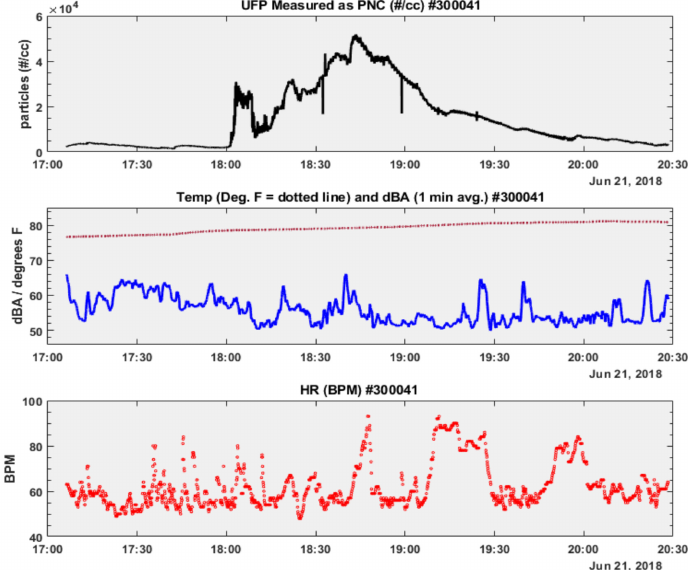
Figure 7. Time-series subplots of PNC, Temp., dBA, Heart Rate: participant # 300041 (21 June 2018).